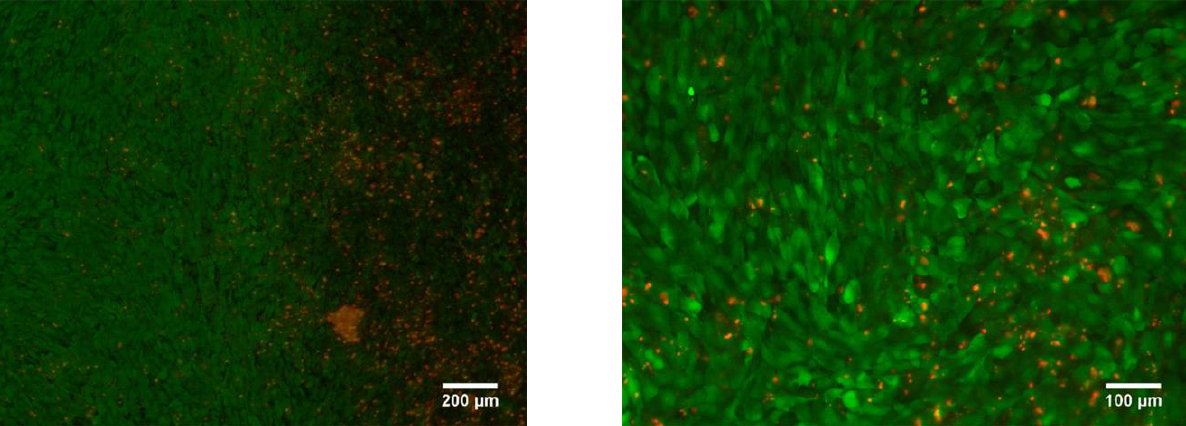
Figure 21. Dense Ti-Nb sample LIVE/DEAD stained with Calcein AM/PI after 7 days of incubation.